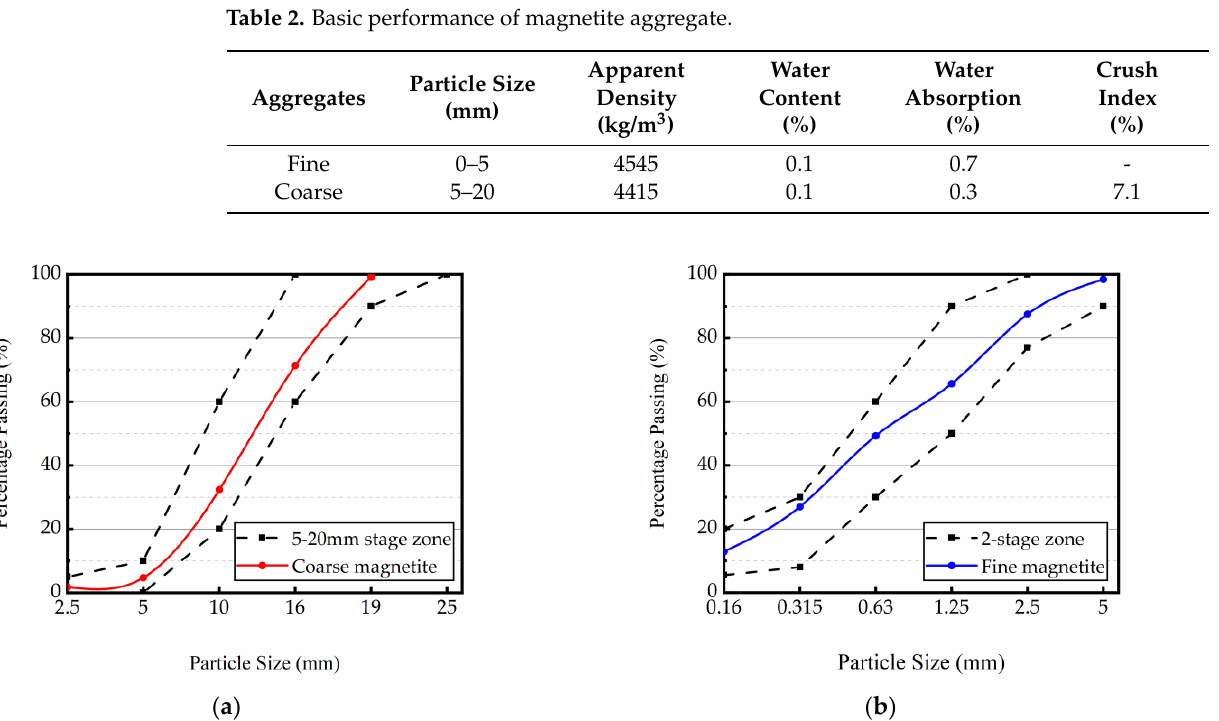
Table 1. Chemical composition of cement and aggregates (wt.%).